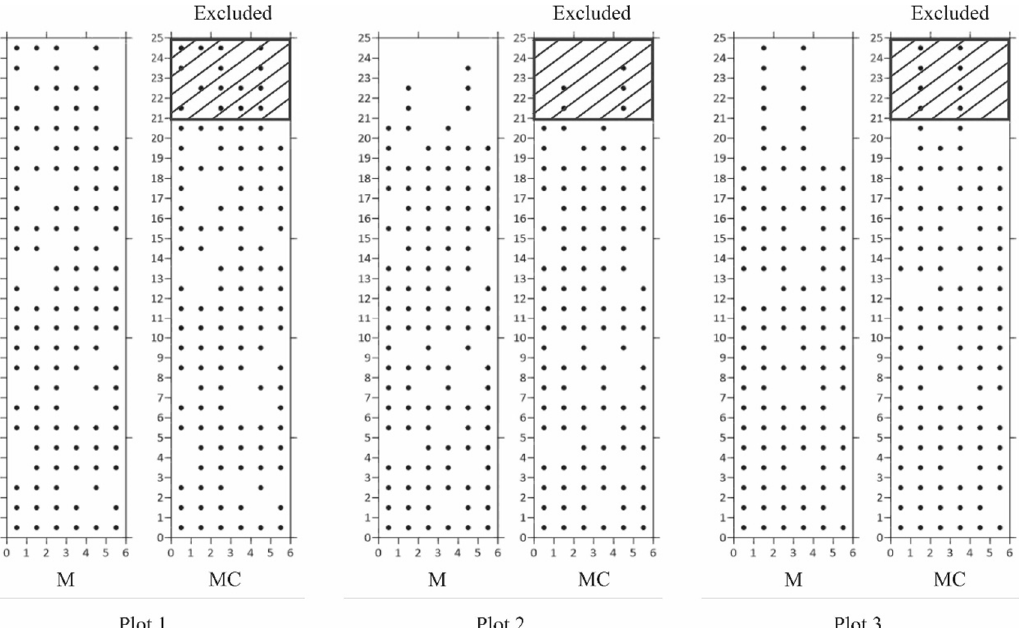
Figure 1. Schematic presentation of all the maize plants (dots) harvested in each plot (M). The upper part of M plots was marked as “excluded” (MC plots) due to the limited number of plants (rows 21–25) in this area (some plants were not emerged) to be distinguished from the rest of the area, where measurements have adequate density, and to improve the overall quality of the mean estimates. Where: M: All measured (all sampled data); MC: Measured cut (without the measurements from the upper part area—lines 21 to